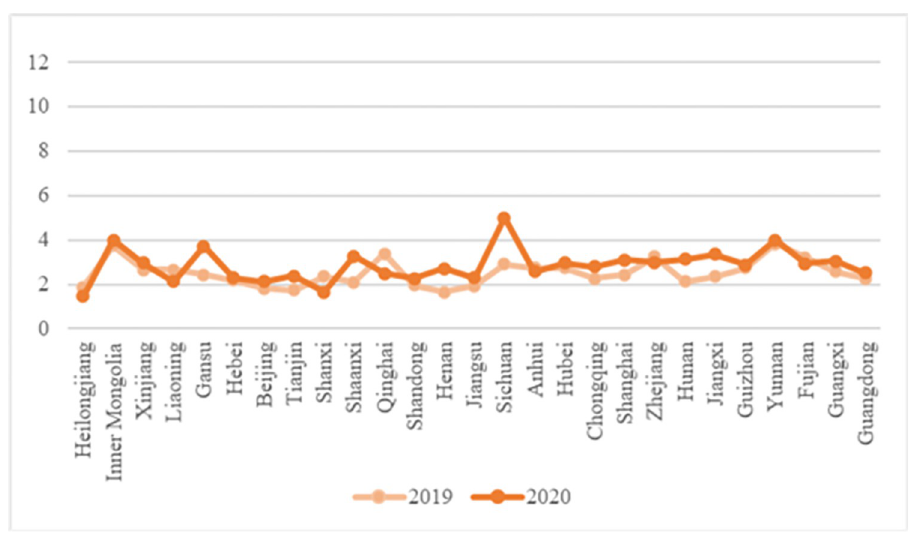
Fig 9. Broken line chart of carrot price comparison across the country.